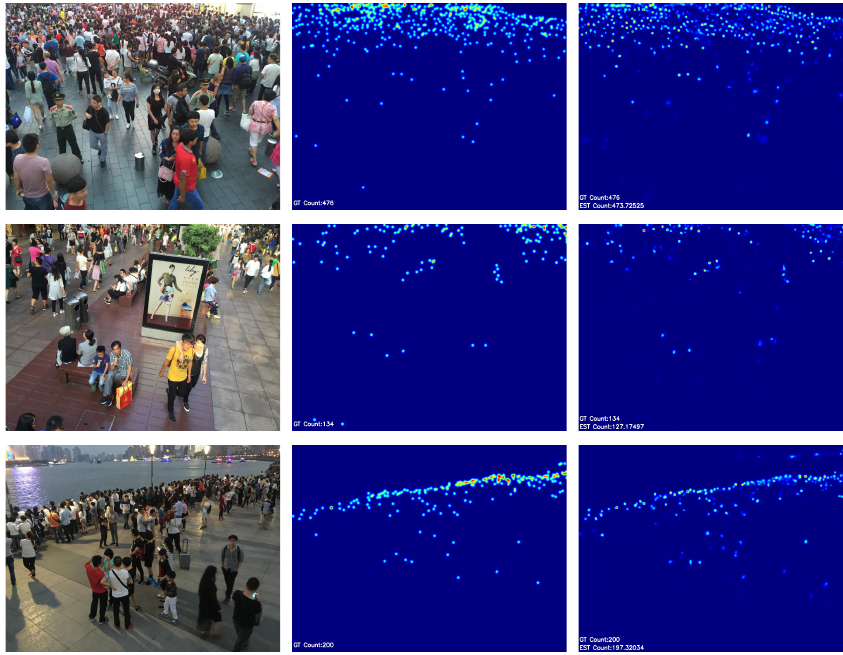
Figure 5: The density map estimated by MSA-CNN on the Shanghai Tech Part_B dataset, the first column is test images, the second column is ground truth density map, and the third column is estimated density map by our approach